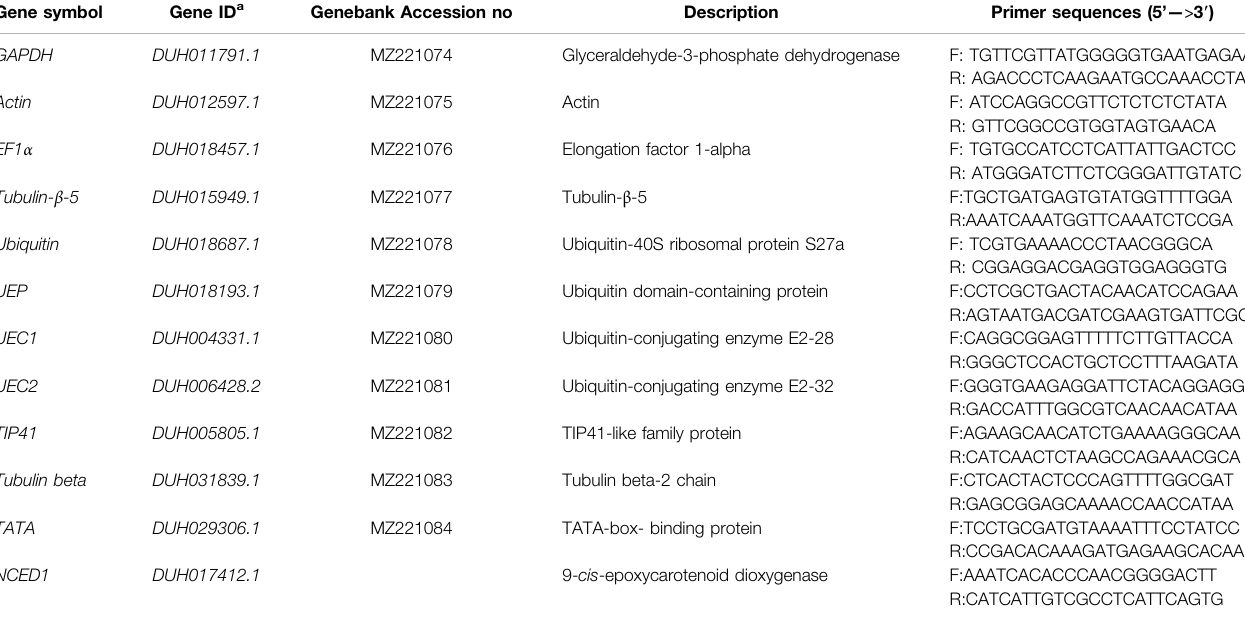
TABLE 2 | Details of primer pairs used in real-time fl uorescence quantitative PCR for candidate genes and validation of genes in R. delavayi